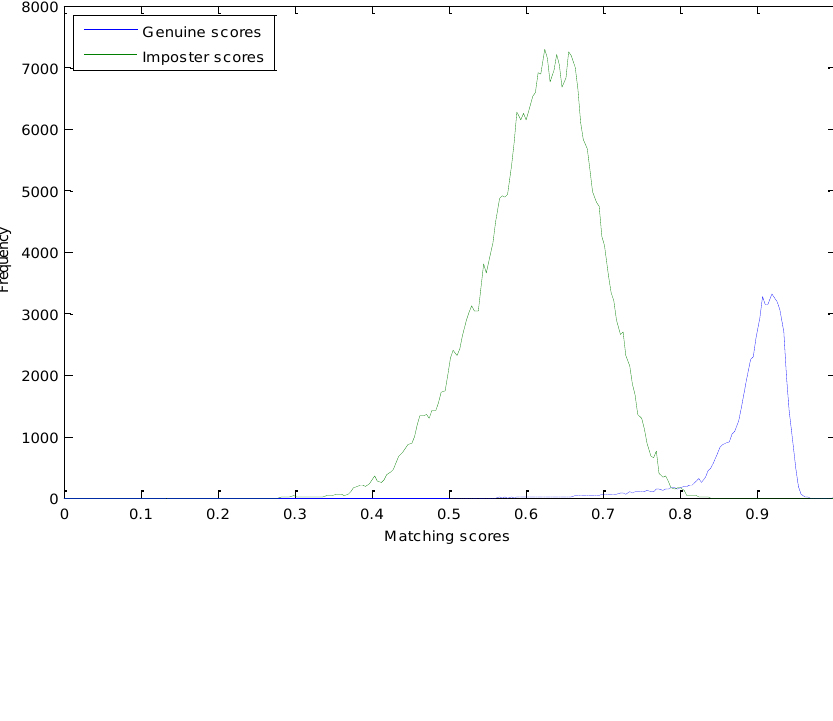
Figure 6. Matching score distribution of the LLBP-based